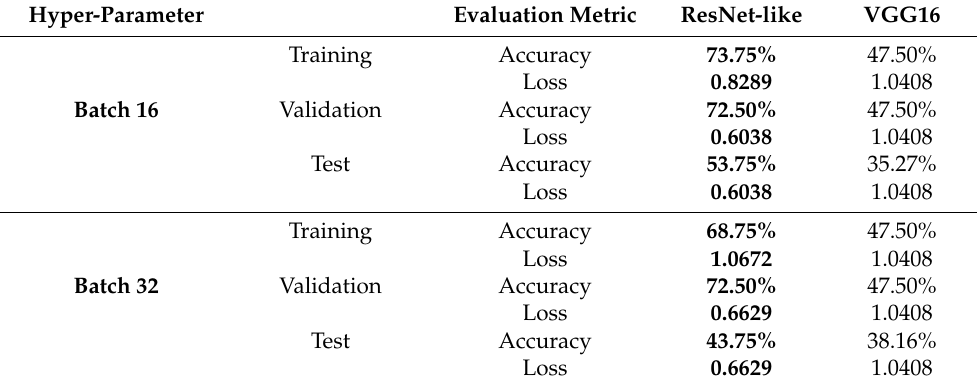
Figure 16. The training loss, validation loss, training accuracy, and validation accuracy of learning rates range from 0.0005 with maximum epochs of 200 and batch size of 32. Table 4. The comparison of performances between hyperparameter batches 16 and 32. ResNet- like trained with batch size 16 is better than the batch size of 32 and it is also better than VGG16 as